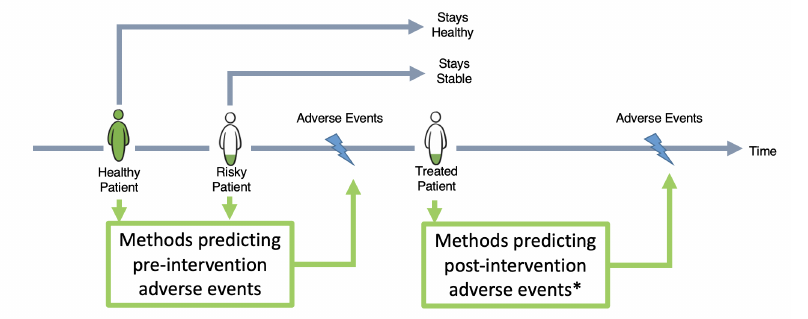
Figure 1. Landscape of different methods in the literature predicting adverse cardiac events. Some methods are designed to predict these events for stable or healthy populations, while others focus on sick and already treated patients. The focus of our study (*) is to predict post-intervention target lesion failure. TLF is defined as the composite of multiple clinical endpoints: cardiovascular death, clinically driven target lesion revascularization, target vessel myocardial infarction, and stent